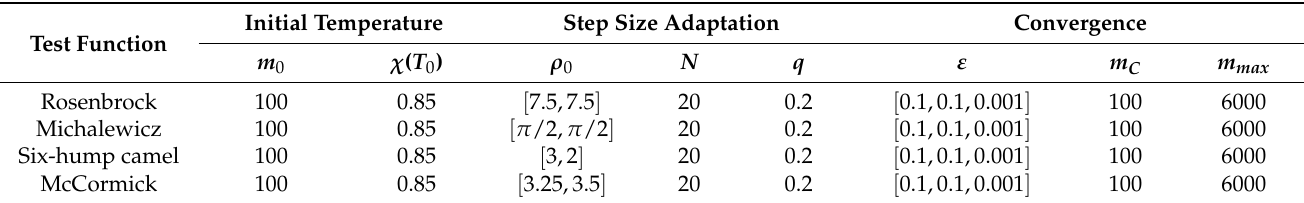
Table 5. Parameters of the simulated annealing algorithm for the different test functions.